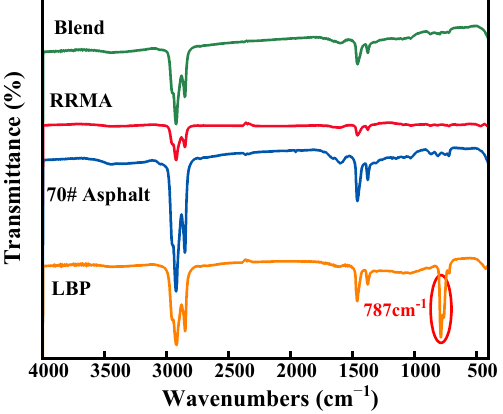
Figure 2. FTIR spectrum of LBP, 70# asphalt, RRMA and Blend.